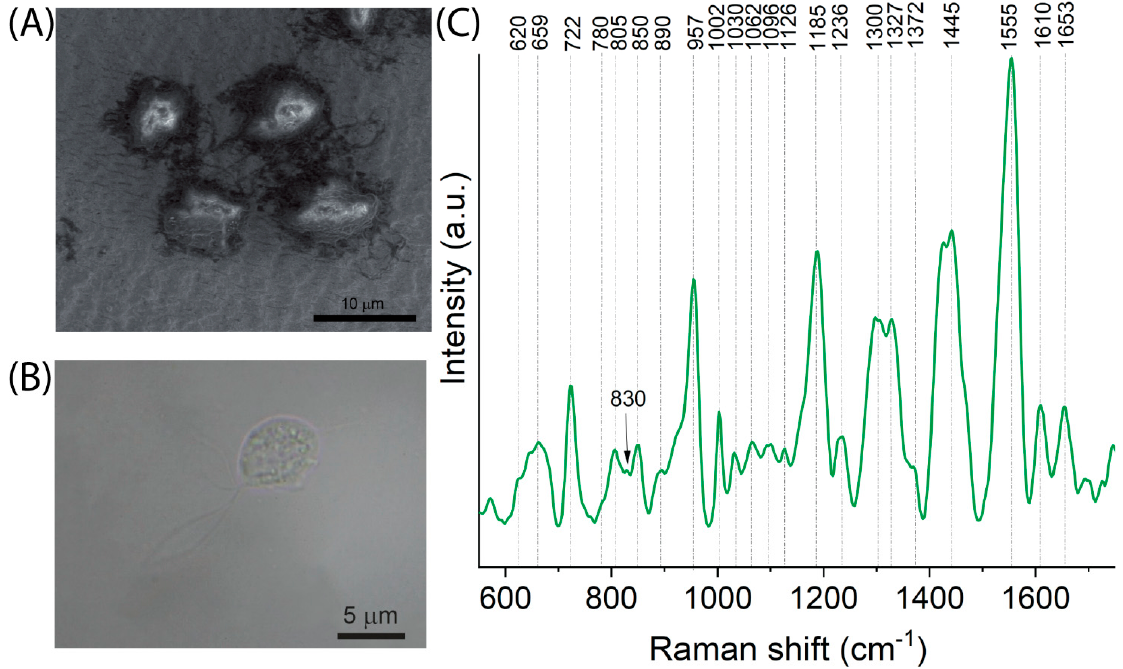
Figure 6. Results of Trichomonas vaginalis analysis: ( A ) SEM images that present cells of T. vaginalis located on SERS substrates and ( B ) microscopic image of T. vaginalis cell and ( C ) averaged SERS spectrum.